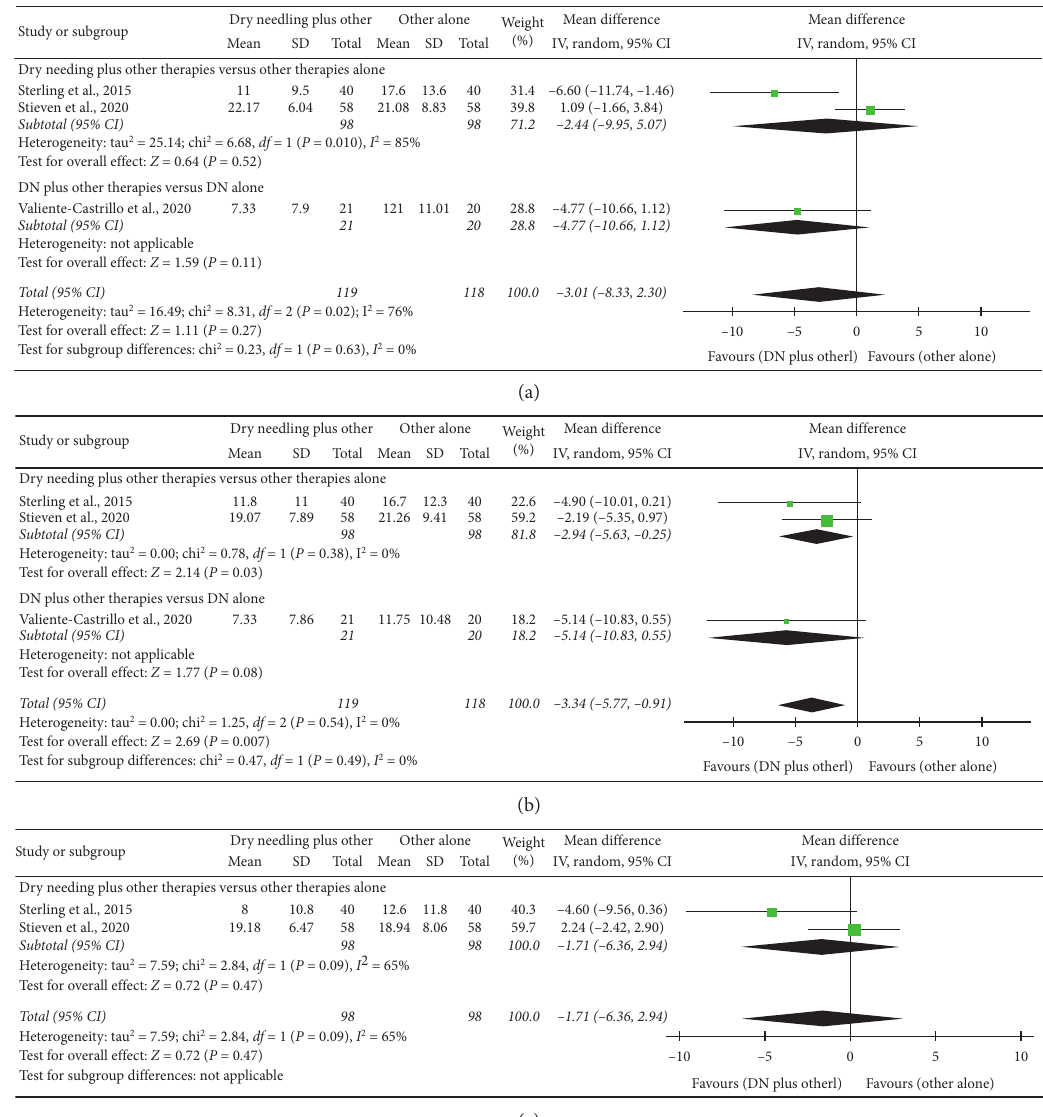
Figure 7: Comparison (mean differences) between the effects of dry needling combined with other interventions against other interventions on pain catastrophism (a) at short-term, (b) at midterm, and (c) at